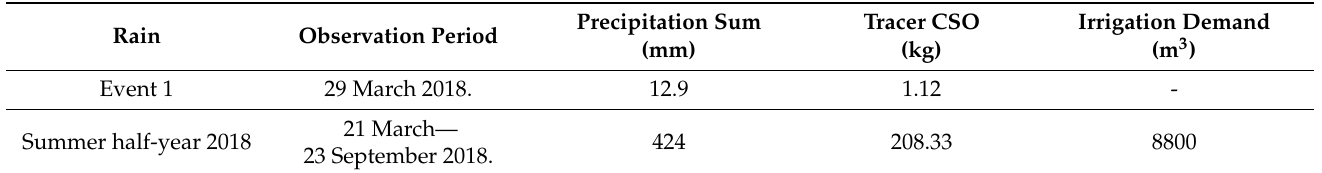
Table 1. Characteristics of the investigated rain events with caused tracer mass in CSO in the reference state without any rain barrels, including required irrigation demand for green areas during the summer-half year (21 March—23 September) 2018.